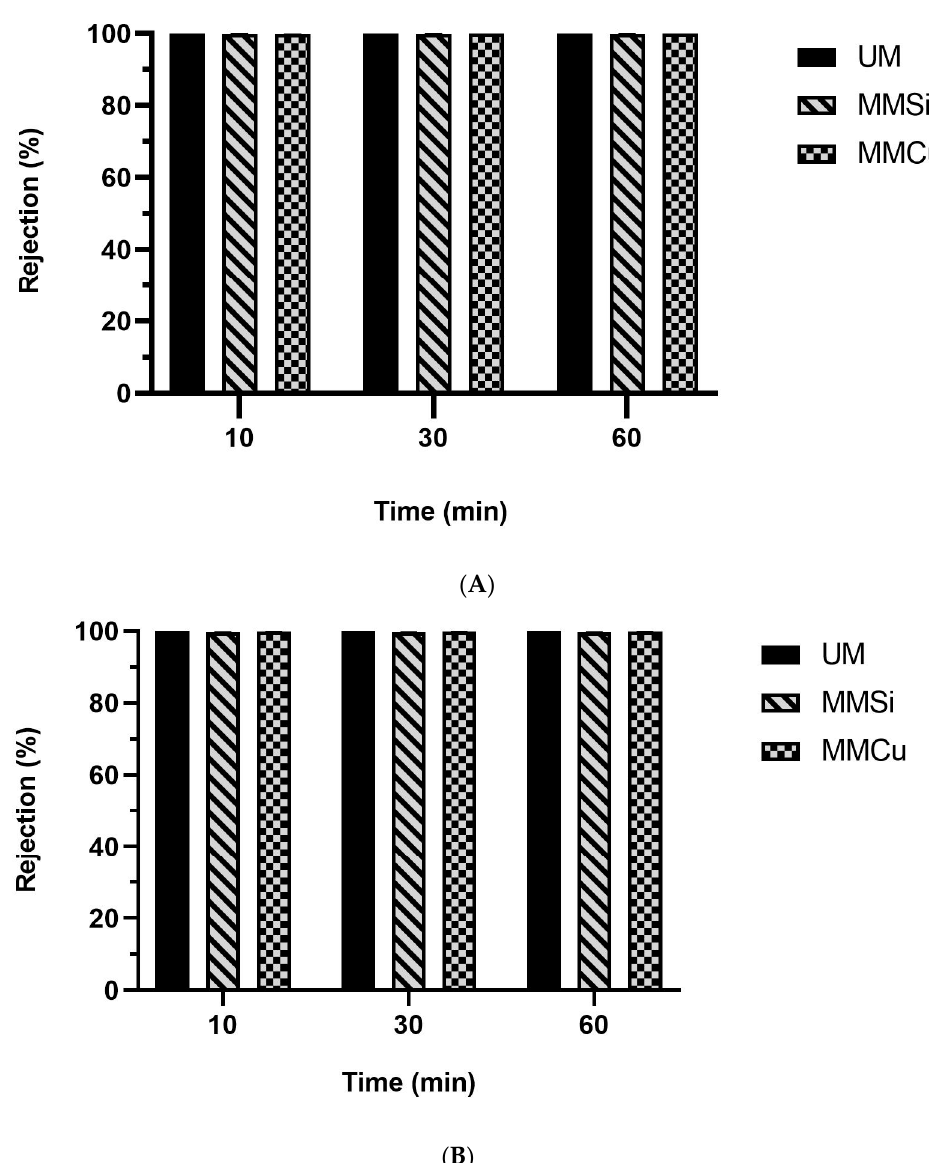
Figure 3. Rejection percentages of total coliforms ( A ) and E. coli ( B ) after filtration of surface water along different experimental times using unmodified (UM) and modified membranes (MM). Error bars represent duplicate results.